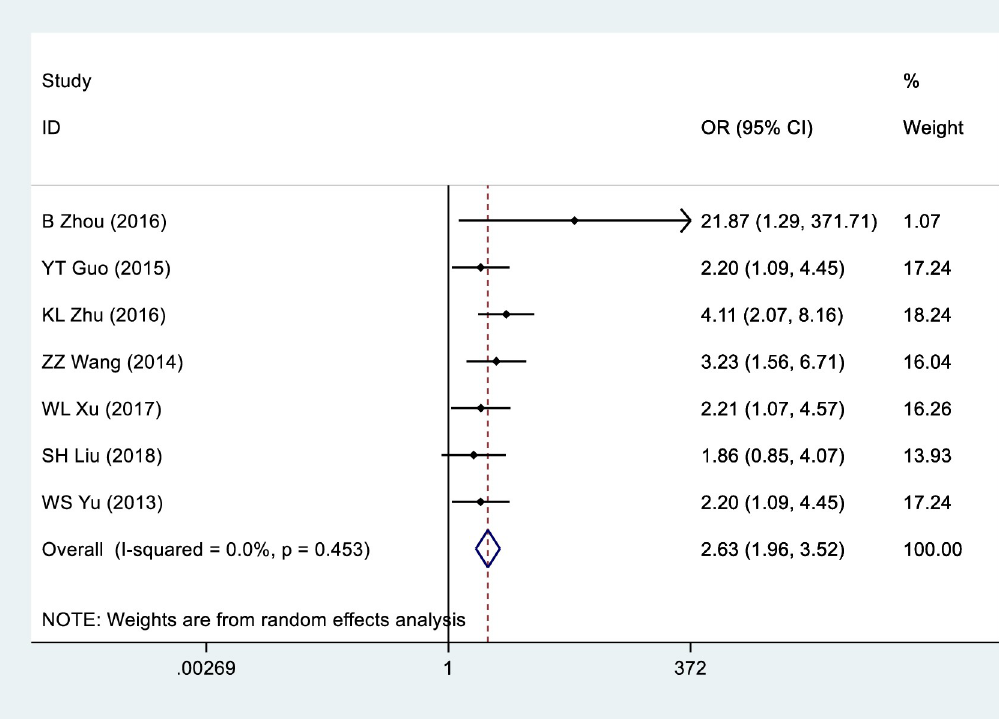
Fig 2. Forest plot of GOLPH3 expression in CRC tissue samples and adjacent normal colorectal tissue samples. The horizontal line represents the range in which the truth value of the study exists. The dots on the horizontal line represent the effect size of a single study, and the size of the dots represents the weight. Diamonds represent the result of the merger.